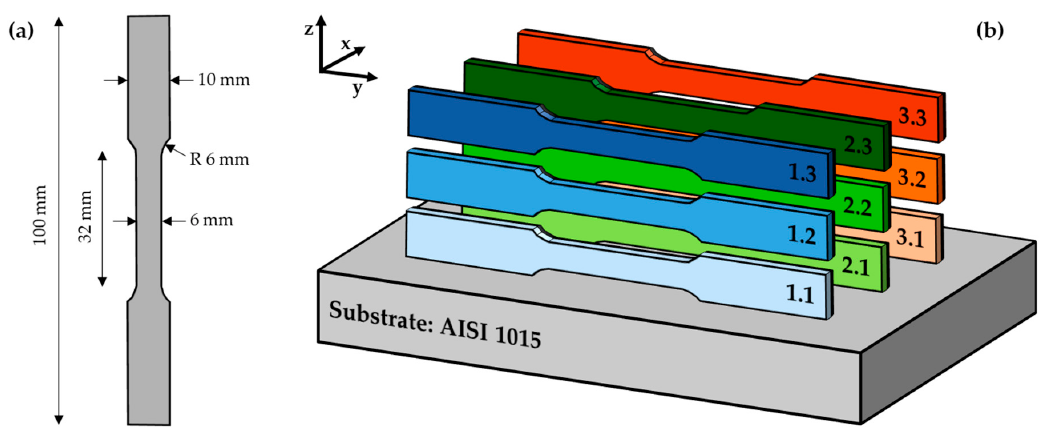
Figure 4. Schematic images of ( a ) a tensile test sample with its dimensions and ( b ) the numbering of the samples for the tensile tests and their location in the walls: ( b.1 ) 1.1, 1.2, 1.3 as-built specimens; ( b.2 ) 2.1, 2.2, 2.3 specimens treated by TT1; and ( b.3 ) 3.1, 3.2, 3.3 specimens treated by TT2.